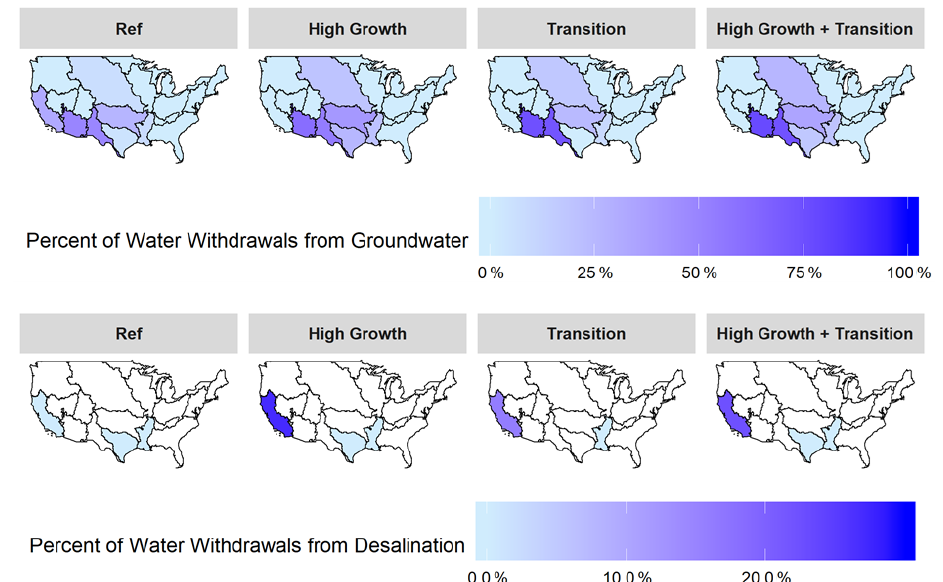
Figure 9. Percentage of total water withdrawals met by groundwater extraction (top row) and desalination (bottom row) by water basin and scenario in 2100.